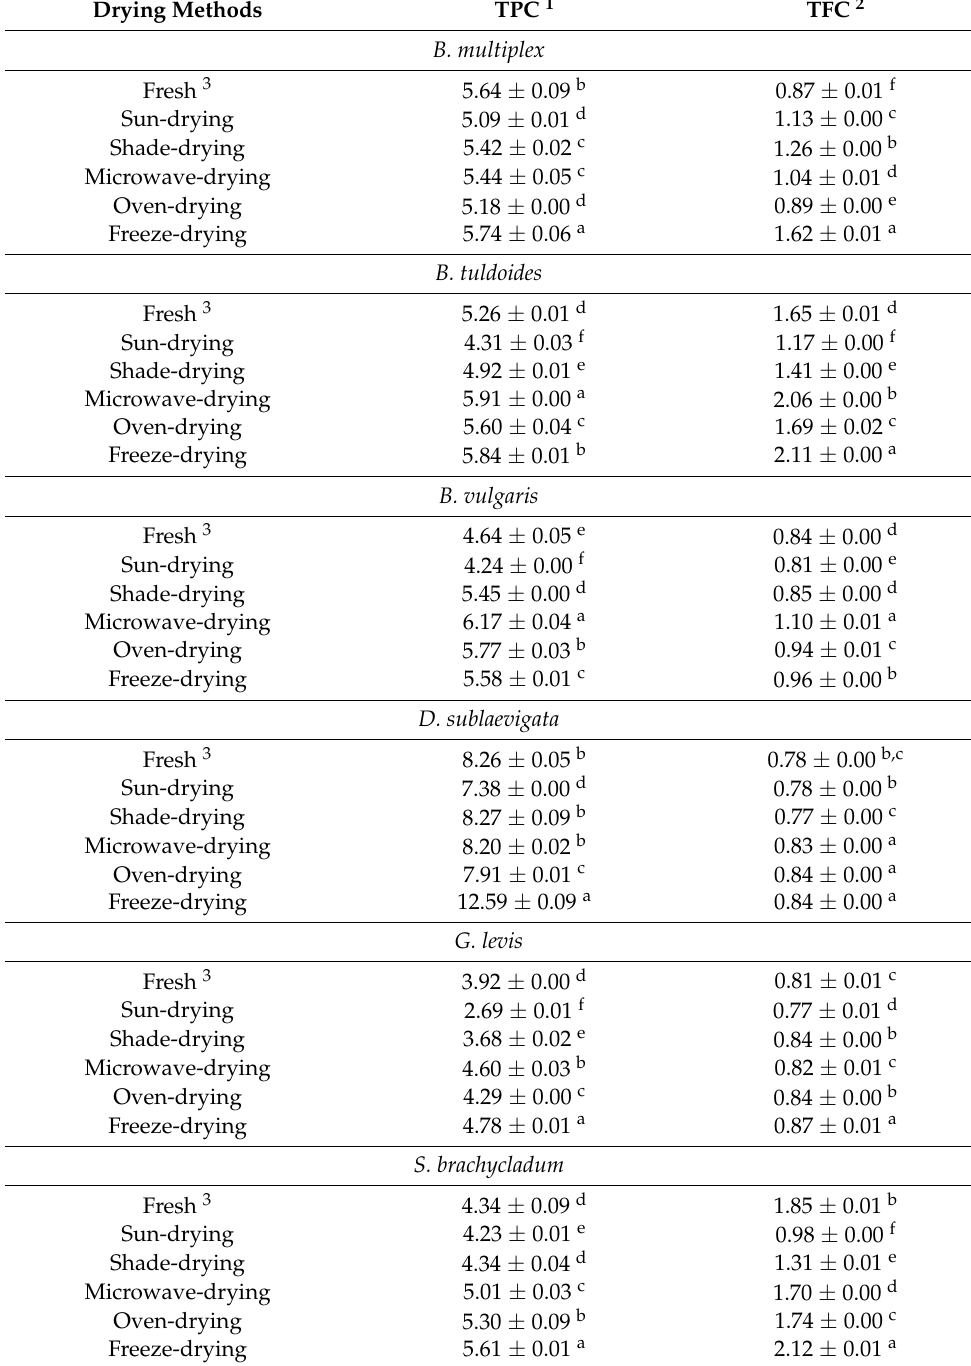
Table 1. The TPC and TFC of the selected bamboo extracts dried with different